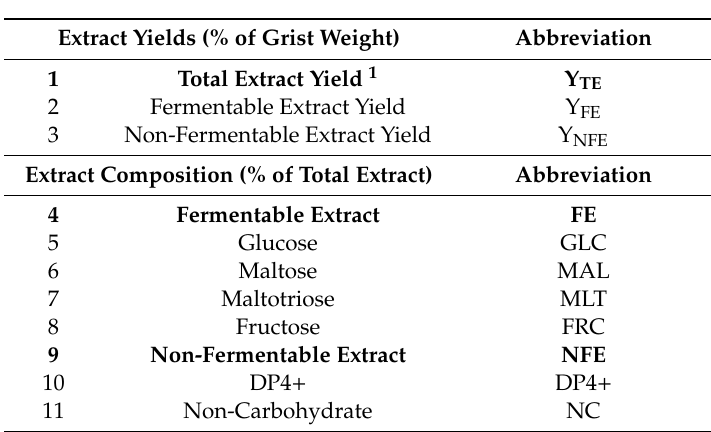
Table 2. Set of eleven calculated